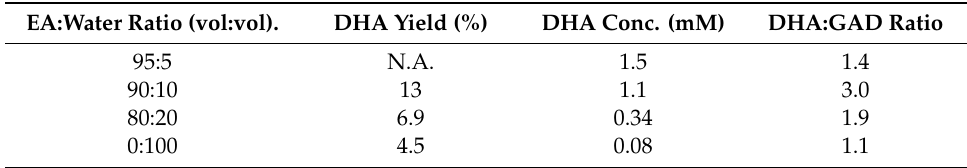
Table 1. E ff ect of ethyl acetate (EA) to water ratio on the performance of biphasic reactor after 240 min irradiation. Figure S5 contains the concentrations of DHA, GAD and glycerol over time. EA + water: